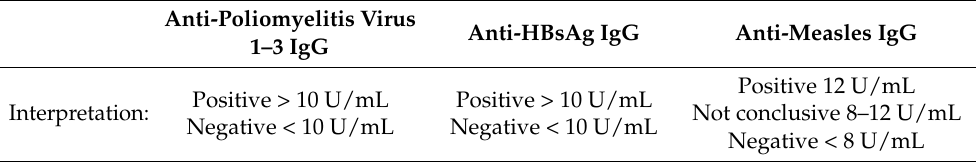
Table 3. Interpretation of the results of ELISA tests concerning Anti-Poliomyelitis virus 1–3 IgG, Anti-HBsAg IgG, and Anti-Measles IgG, according to manufacturers’